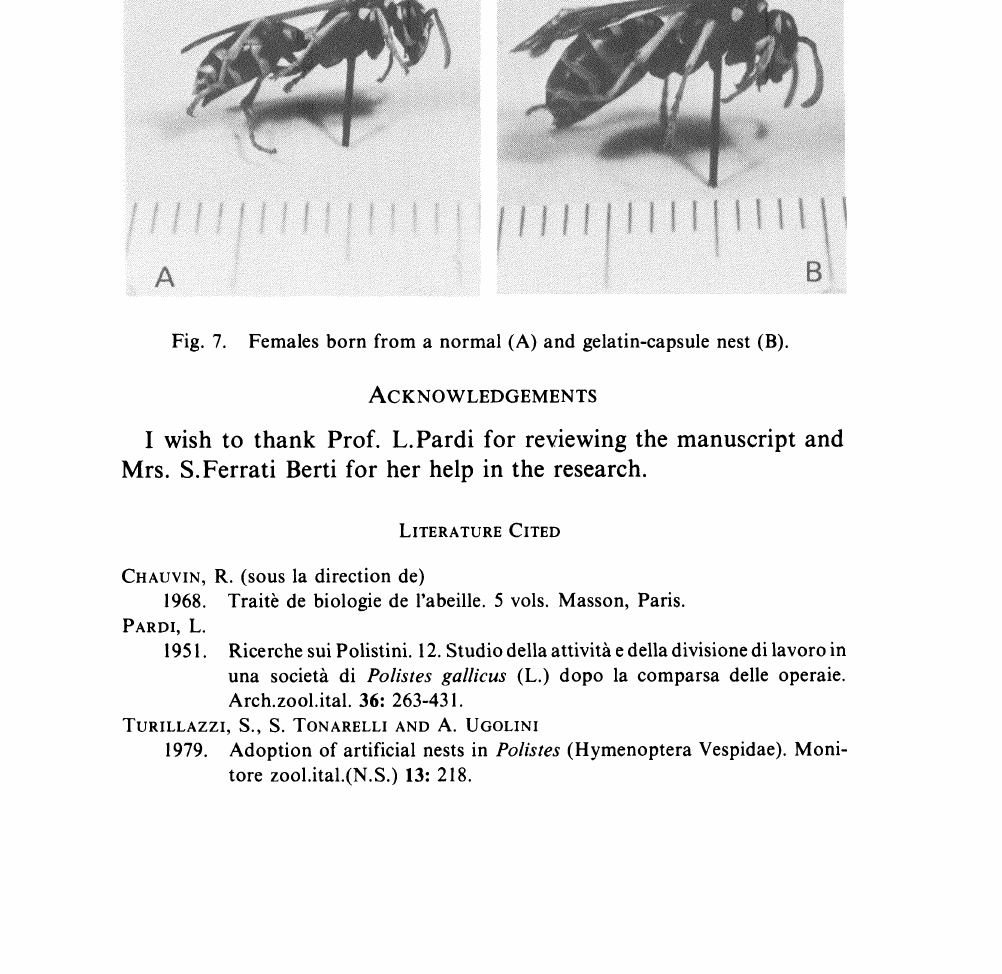
Fig. 7. Females born from a normal (A) and gelatin-capsule nest